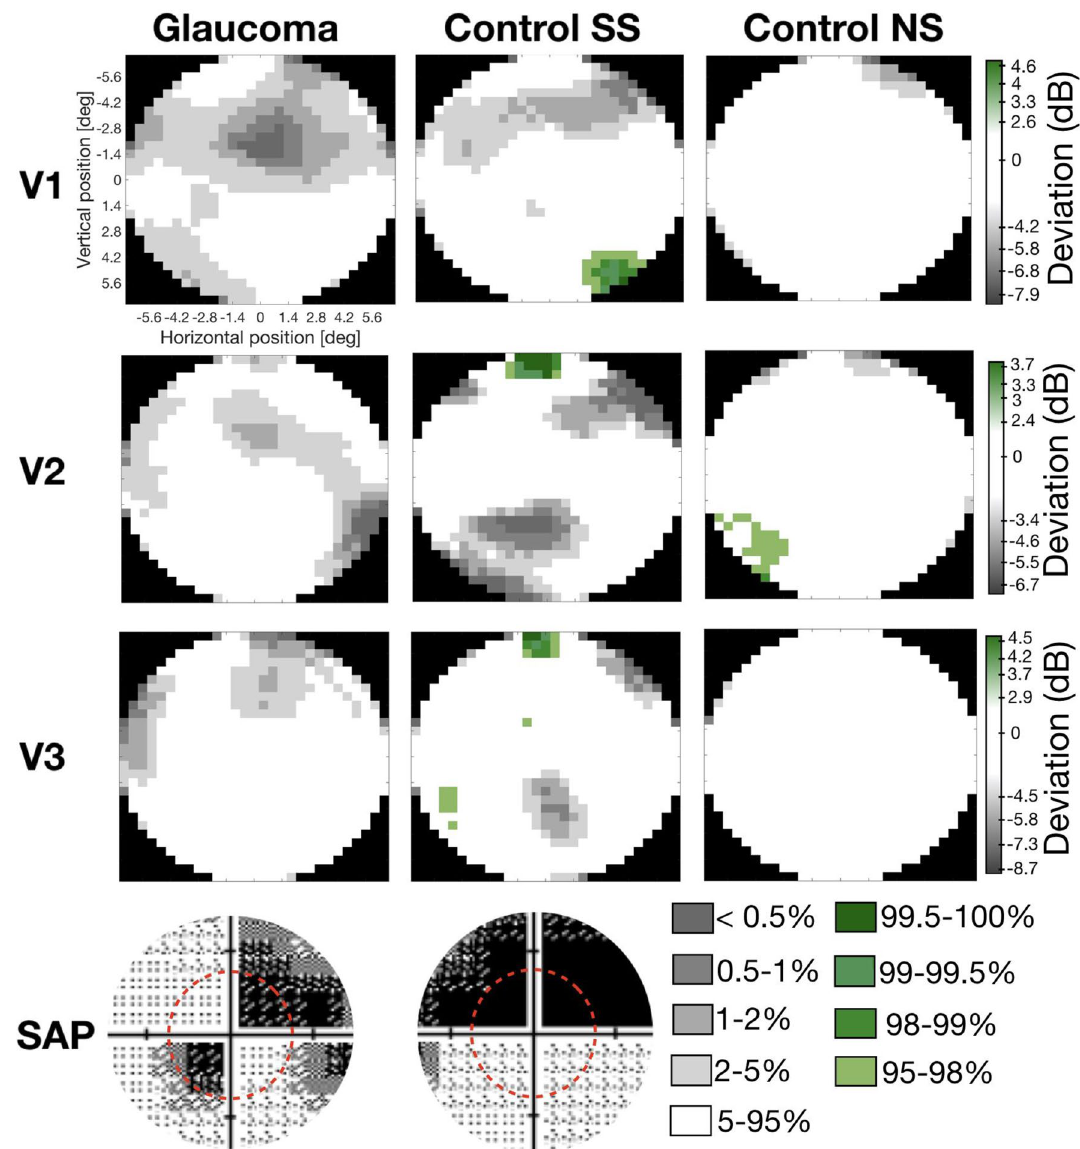
Figure 5. Comparison of the visual field reconstructions for visual areas V1, V2 and V3 of a participant glaucoma (G10) and the matched control participant (C02) with (SS) and without simulation (NS). The visual field reconstructions are based on the deviation between Glaucoma and Control SS from the average controls NS group (excluding the control participant with the SS matched to the glaucoma patient). The color code corresponds to the deviation to the CI, in particular regions of the VF within 5–95% CI are coded in white while the gray and green tones correspond to the < 5% and > 5% normal limits, respectively. The bottom panel shows the glaucoma participant SAP test and dashed red line corresponds to the VF that could be mapped using fMRI. The visual field reconstructions were obtained using pRFs estimated using the micro-probing